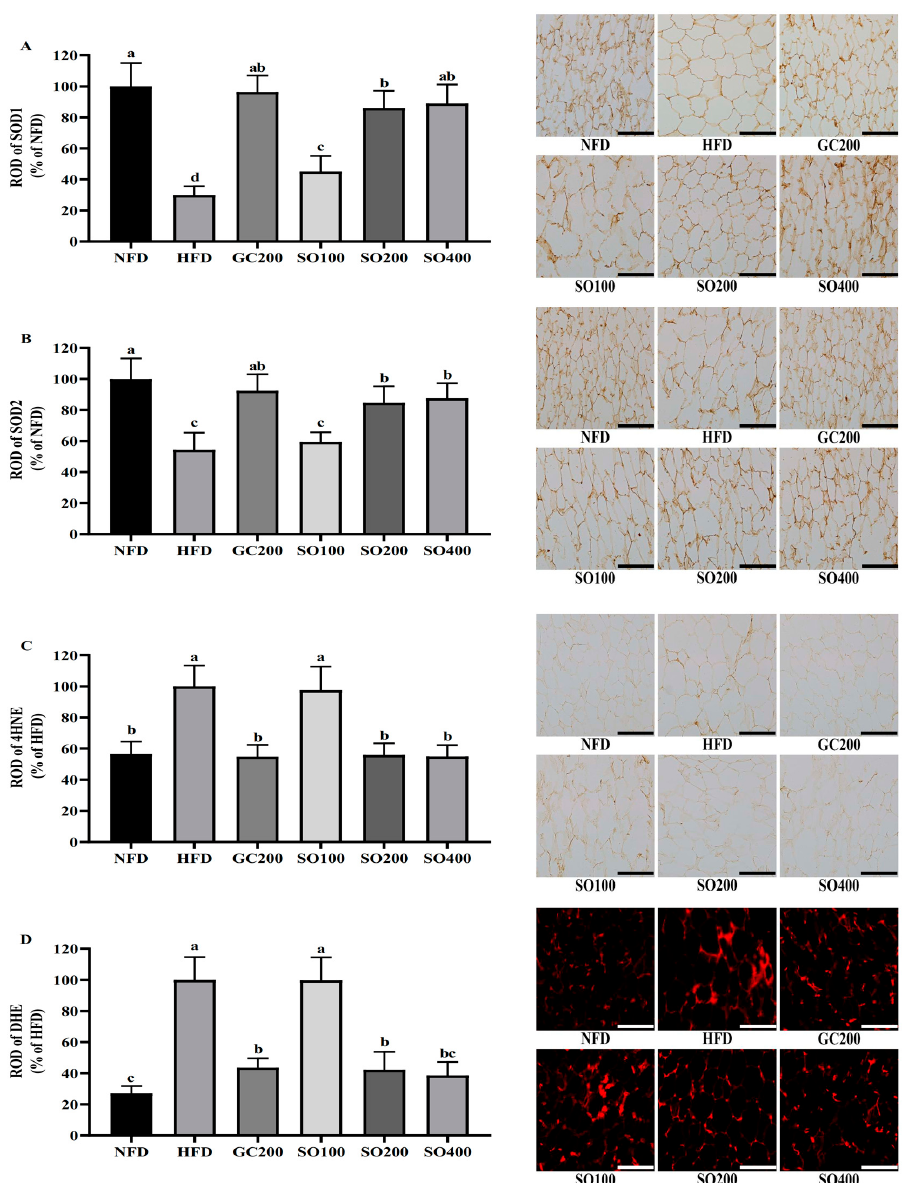
Figure 8. Effect of SO on oxidative stress in WAT of HFD-induced obese mice: ( A , B ) SOD1 and SOD2 expression measured by immunohistochemistry in WAT; ( C ) lipid peroxidation products determined by immunohistochemistry of 4HNE in WAT; ( D ) ROS production measured by histofluorescence staining of DHE in WAT. GC200, HFD supplemented with 200 mg/kg/day of GC; SO100, HFD supplemented with 100 mg/kg/day of SO; SO200, HFD supplemented with 200 mg/kg/day of SO; SO400, HFD supplemented with 400 mg/kg/day of SO. The scale bar represents a length of 50 μ m. Values are expressed as mean ± SD of experiments. Different letters indicate significant differ- ences at the level of p < 0.05.